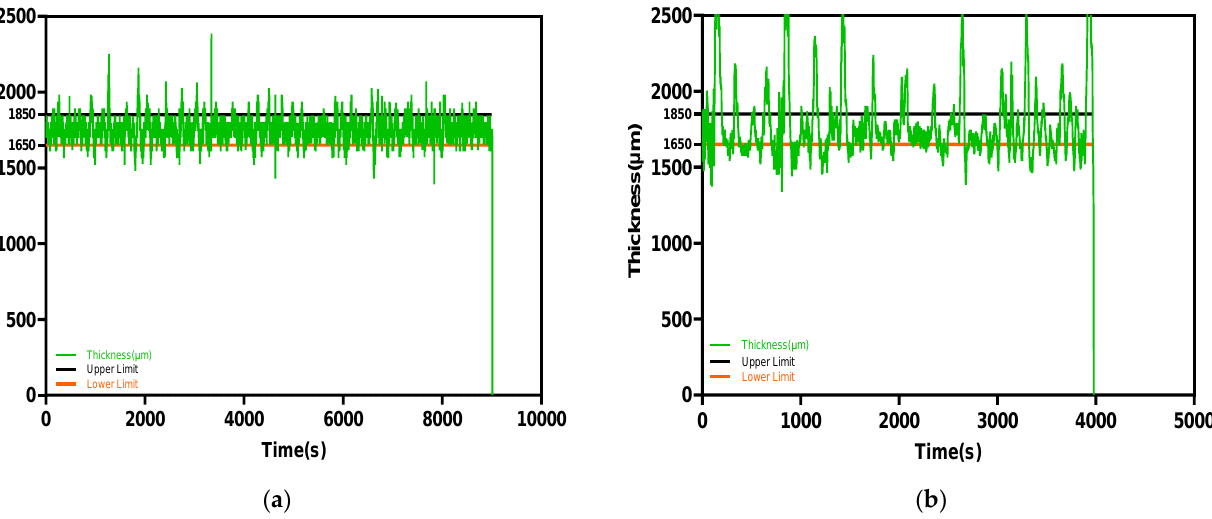
Figure 3. The filament thickness varies with time profile: ( a ) drug-loaded: 1.75 ± 0.08 mm; ( b ) placebo: 1.78 ± 0.26 mm.